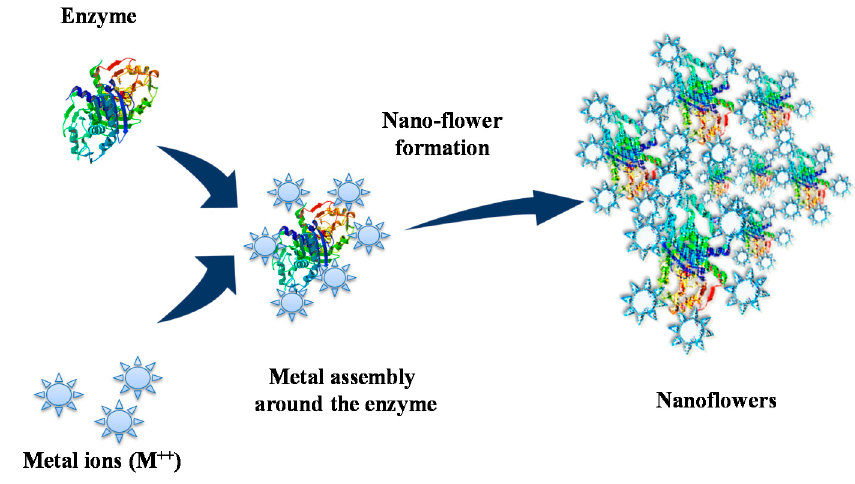
Figure 3. Schematic enzyme representation of enzyme immobilization using nanoflowers formation strategy.